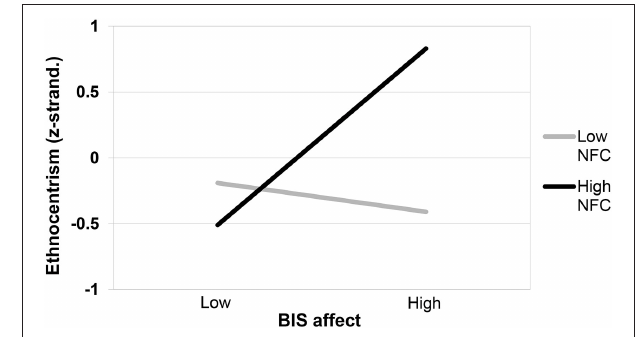
FIGURE 7 | Ethnocentrism as a function of need for closure (NFC) and BIS affect. BIS, behavioral inhibition system.